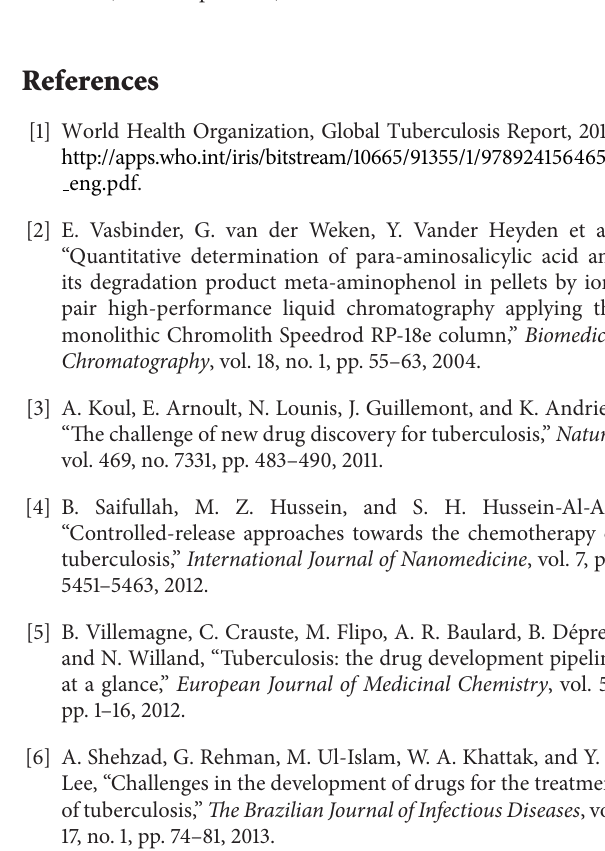
Figure 12: (a) 24-hour lung cells MRC-5 PAS-ZLH (nanocomposite A) and the carrier ZLH. (b) 48-hour lung cells MRC-5 PAS-ZLH (nanocomposite-A) and the carrier ZLH. (c) 72-hour lung cells MRC-5 PAS-ZLH (nanocomposite-A) and the carrier